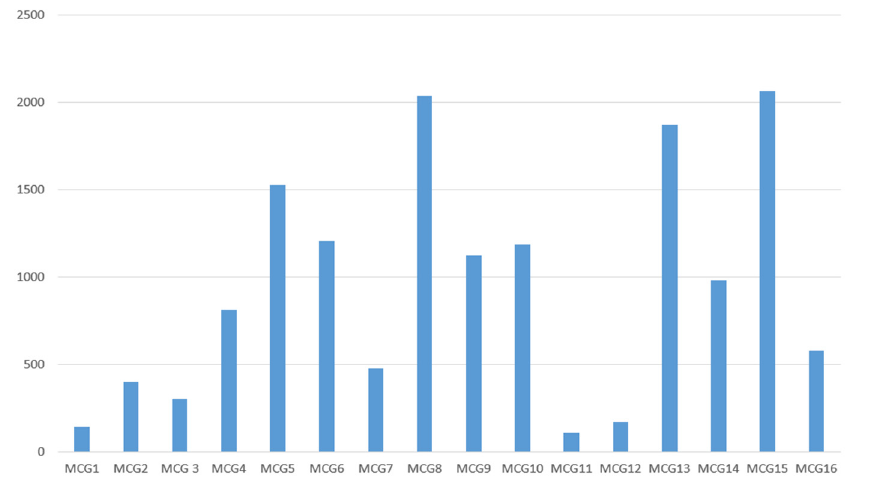
Figure 4. Distribution of recommended merchant category groups